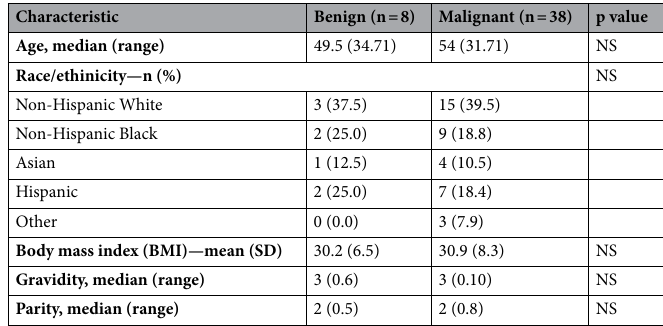
Table 1. Characteristics of the study population. NS not significant.